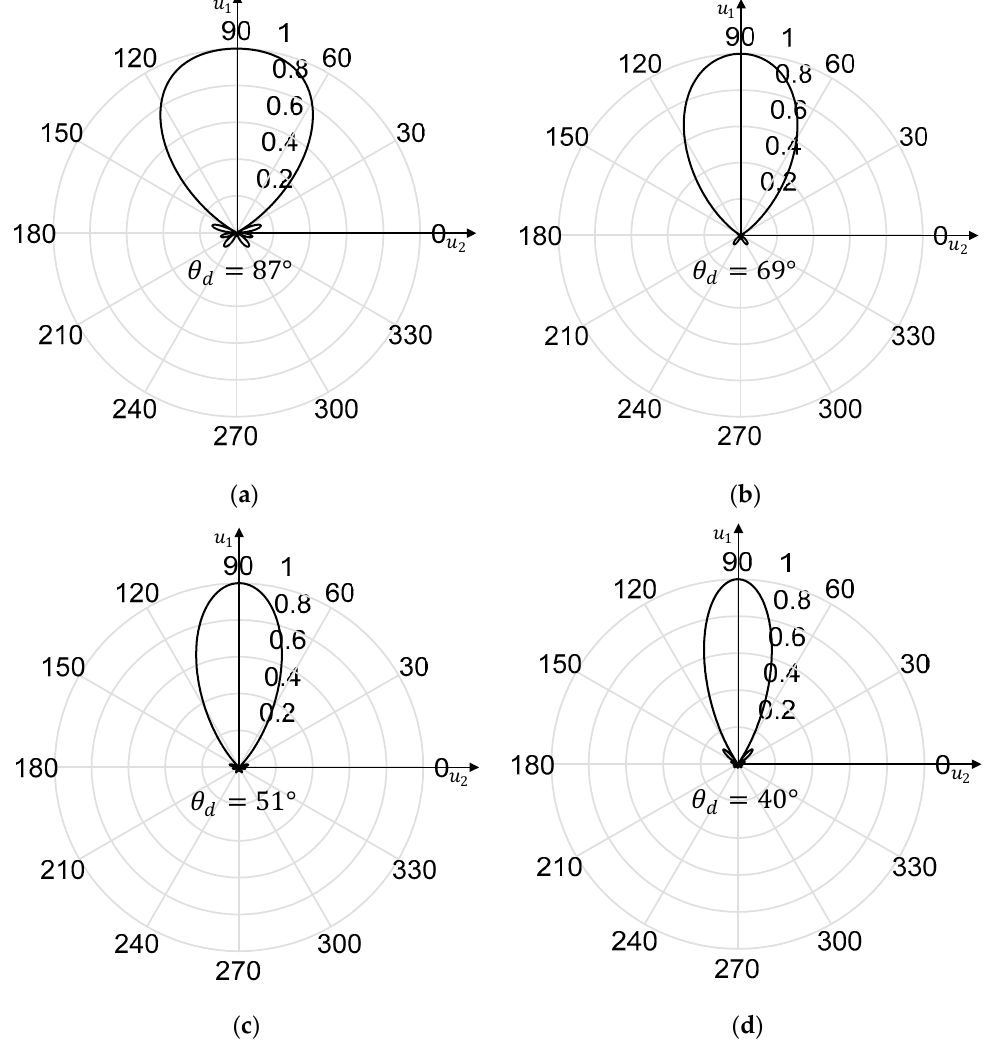
Figure 5. The sound fields and divergence angles of the MSTs with different lengths: ( a ) 2L = 30 mm; ( b ) 2L = 50 mm; ( c ) 2L = 70 mm; ( d ) 2L = 90